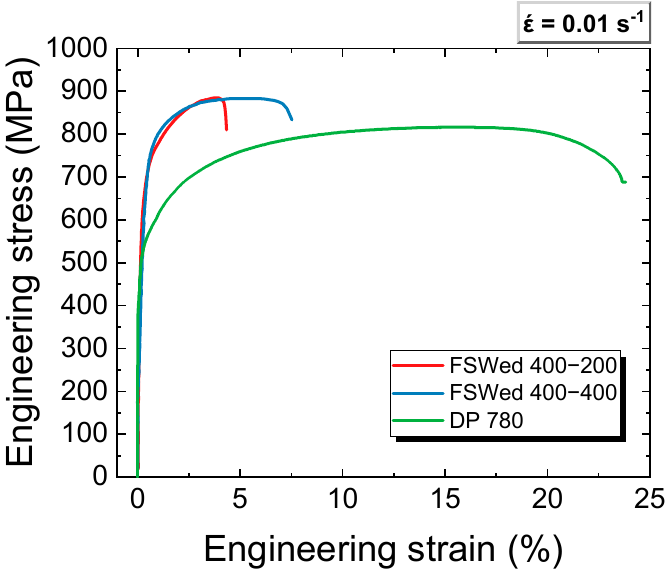
Figure 4. The engineering stress-strain curves of as received DP780 steel and FSWed samples. Table 3. Tensile properties of DP 780 steel and FSWed joints.